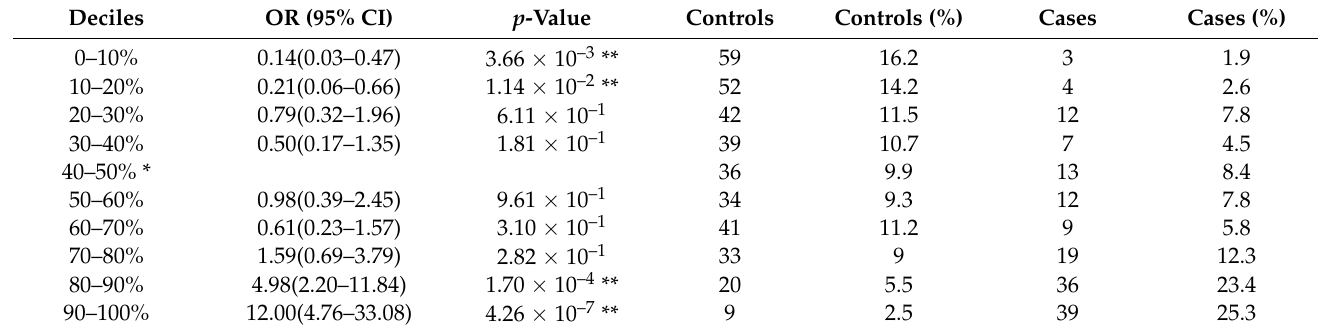
Table 7. ORs, 95% CI and distribution of cases and controls in deciles of the final multivariate model before imputation. Deciles OR (95% CI) p -Value